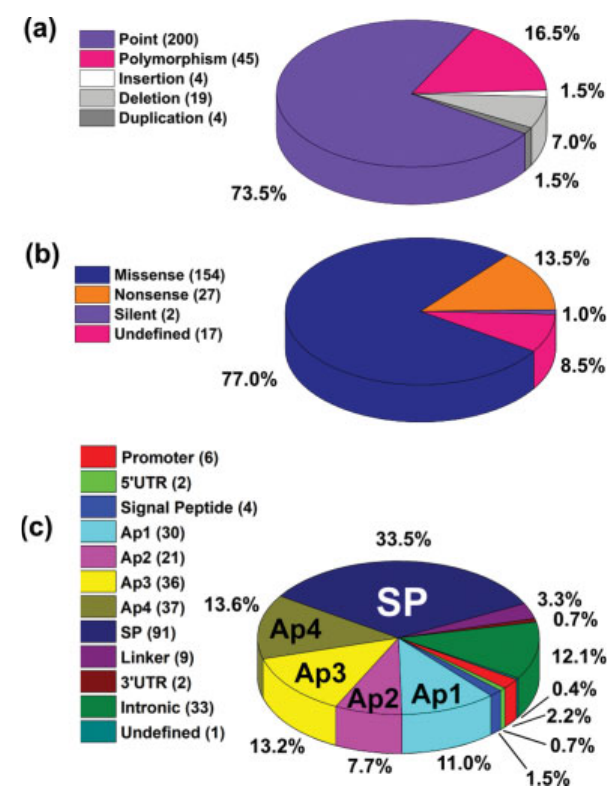
Fig. 2 Distribution of the 272 variants found in the F11 gene. The panels (a-c) indicate breakdowns of the 272 FXI variants into variant type, effect and location within the F11 gene sequence. The charts illustrated here distinguish the non-disease associated polymor- phisms from the disease-associated genetic variants. (a) The relative frequencyof fi ve different typesof unique variantsinthe F11gene. (b) Effect of the 200 point variants found in the F11 gene sequence. (c) Distribution of the 272 FXI variants across the F11 gene sequence and FXI protein domains. Note, the variant in the unde fi ned category is a 31.5kb deletion that cannot be assigned to a single